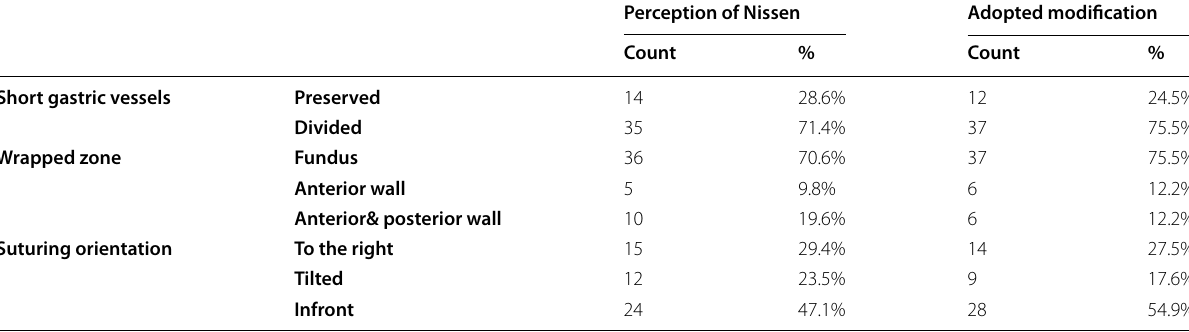
Table 1 Participant’s conceptions of and changes to the Nissen wrap design